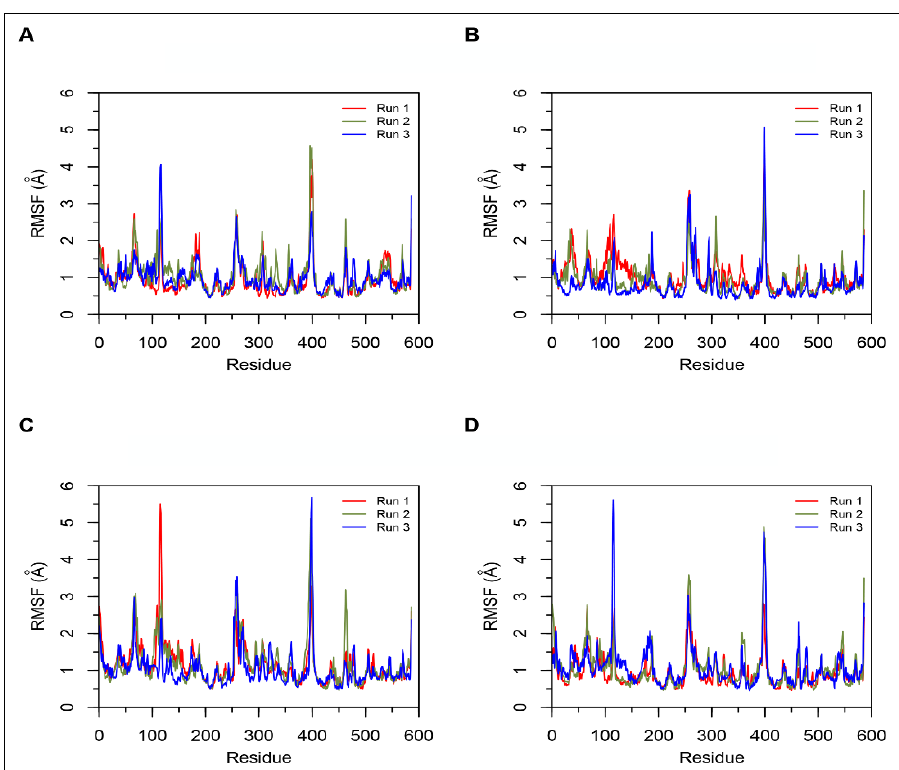
Figure 4. Root mean square fluctuation (RMSF) plots obtained from three independent 200 ns simulations of ACE. Data from the three runs are shown in red, green and blue. ( A ) Simulations of ACE-LVVYPWTQRF complex; ( B ) Simulations of ACE-LVVYPWTRRF complex; ( C ) Simulations of ACE-YPWTQRF complex; and, ( D ) Simulations of ACE-YPWTRRF complex.